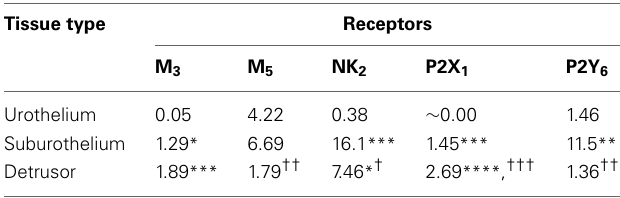
Table 2 | Gene expression level for receptor transcripts in urothelium, suburothelial, and detrusor tissues.